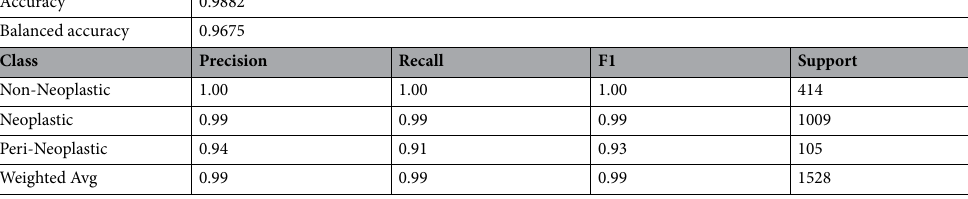
Table 1. Disease state